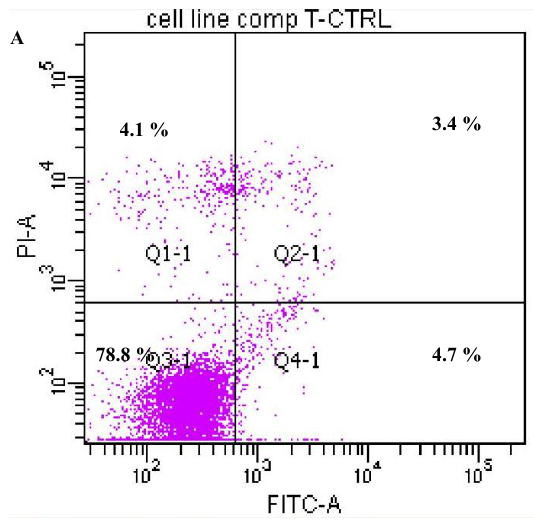
Figure 4. The effect of thymoquinone on early apoptosis of CEMss cells. CEMss cells were exposed to1.5 µg/mL and incubated at 37 °C in a CO incubator. After staining with 2 FITC-conjugated Annexin V and PI, cells were analyzed by fl ow cytometry. Control cells received no drug treatments. The early apoptotic events (Annexin+/PI-) are shown in lower right quadrant (Q4-1) of each panel. Quadrant (Q2-1) represents Annexin+/PI+ late stage of apoptosis/dead cells. (A) The CEMss control (n = 2). (A–C) The effects of 0, 24 and 48 h exposure (respectively) of CEMss cells to